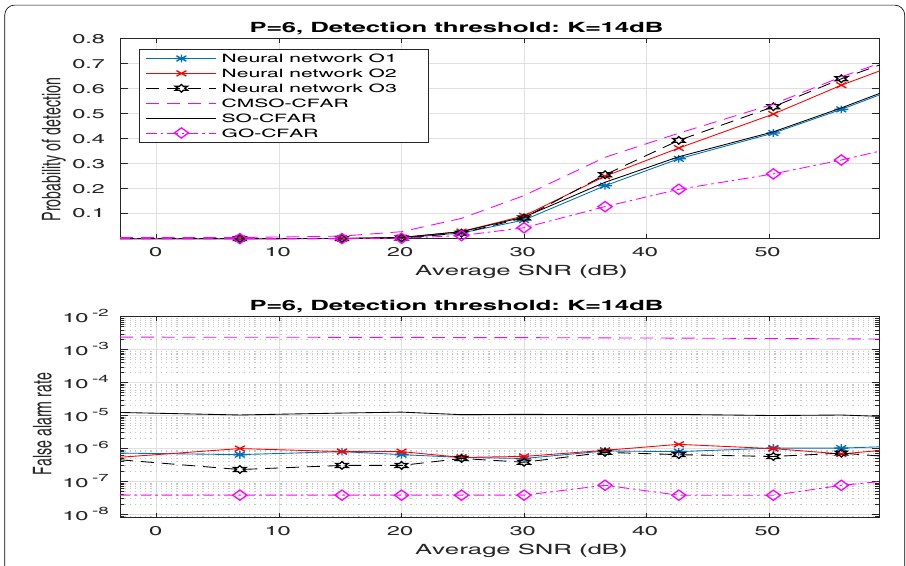
Fig. 6 P D and P FA , Noise-only scenario, 50 x 2 network, P =